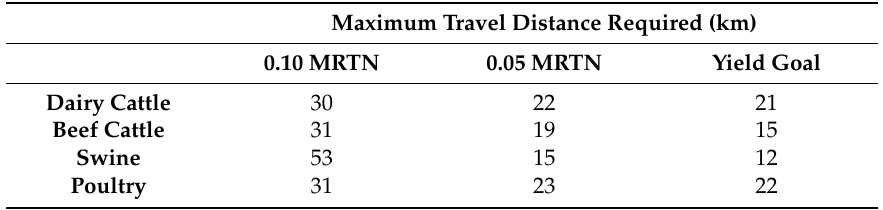
Table 7. Maximum Travel Distance Required Assuming No Cap on Manure Haul Distance.